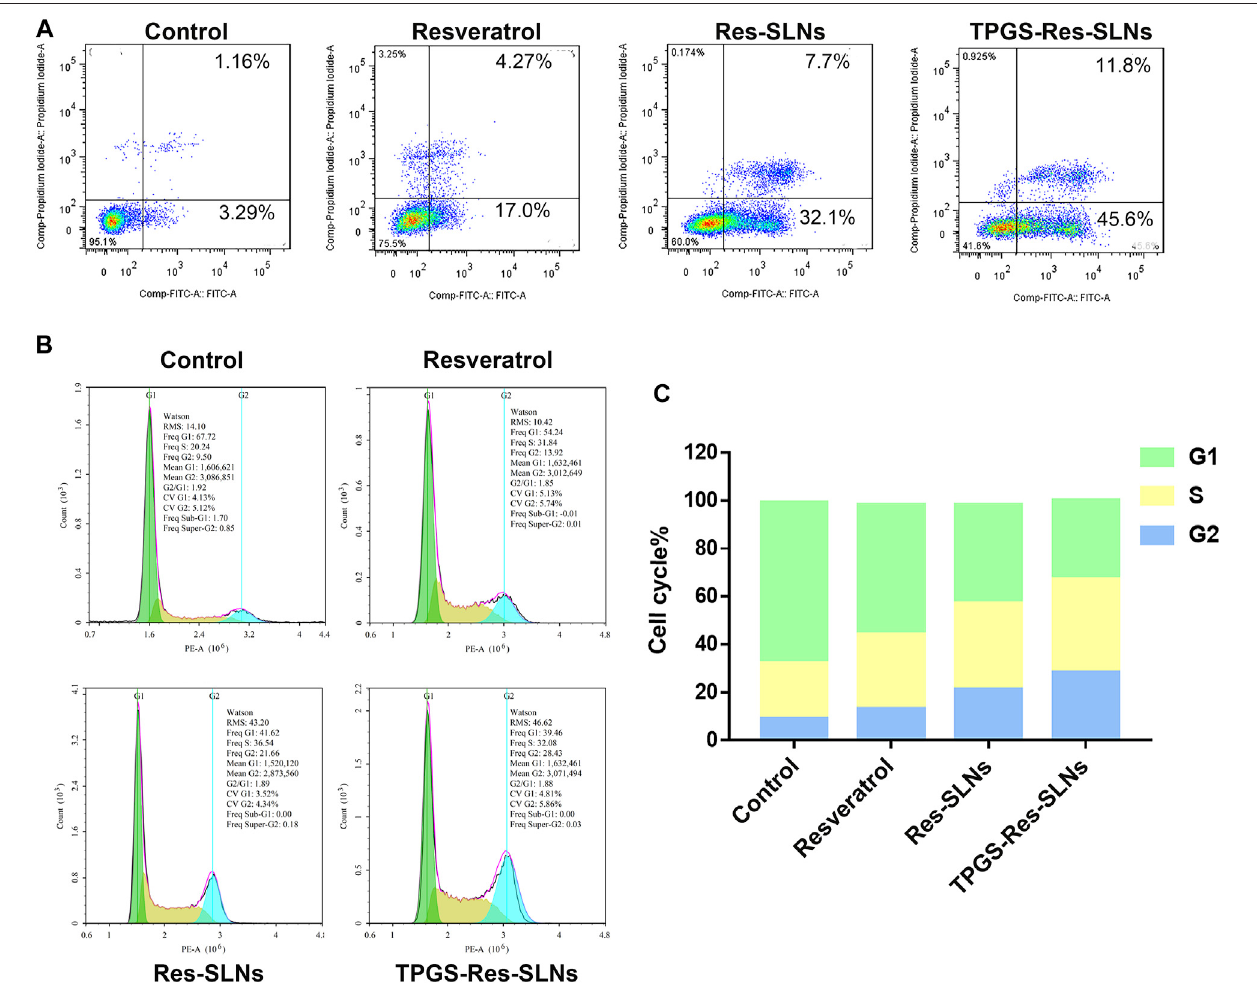
FIGURE 4 | TPGS-Res-SLNs induced apoptosis of SKBR3/PR cells. (A) Assessment of cellular death (apoptosis and necrosis) using Annexin V-FITC/PI staining after incubation for 24 h. SKBR3/PR cells were incubated with Resveratrol, Res-SLNs and TPGS-Res-SLNs for 24 hours. (B) Flow cytometry analysis of cell cycle phase distribution in SKBR3/PR cells. (C) Histogram showing the cell cycle distribution after treatment with Resveratrol, Res-SLNs and TPGS-Res- SLNs.